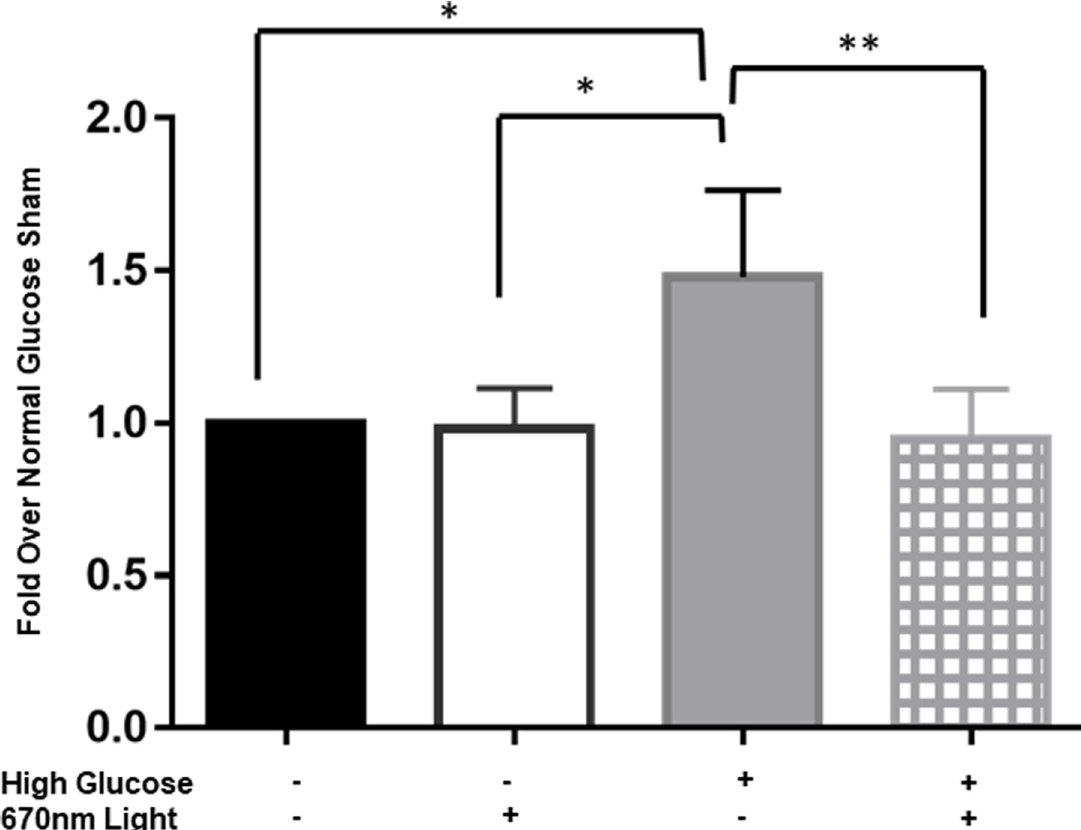
Fig 4. 670nm light treatment diminishes NF κ B activity under high glucose conditions in Muller cells. Bar graph showing Mu¨ller cells were cultured in either normal glucose (black bars and white bars) or high glucose medium (gray bars and hashed bars) for 72 hours while transfected with NF κ B-luciferase. NF κ B activity was analyzed via reporter gene assay, normalized to the transfection control, Renilla, and then treatments were normalized to normal glucose, sham conditions. 670nm (white bars and hashed bars) or sham control (black bars and gray bars) was applied to the cells at 4.5 J/cm 2 daily. One-way ANOVA statistical analysis yielded � p > 0.05, �� p < 0.01 Four separate experiments were performed in